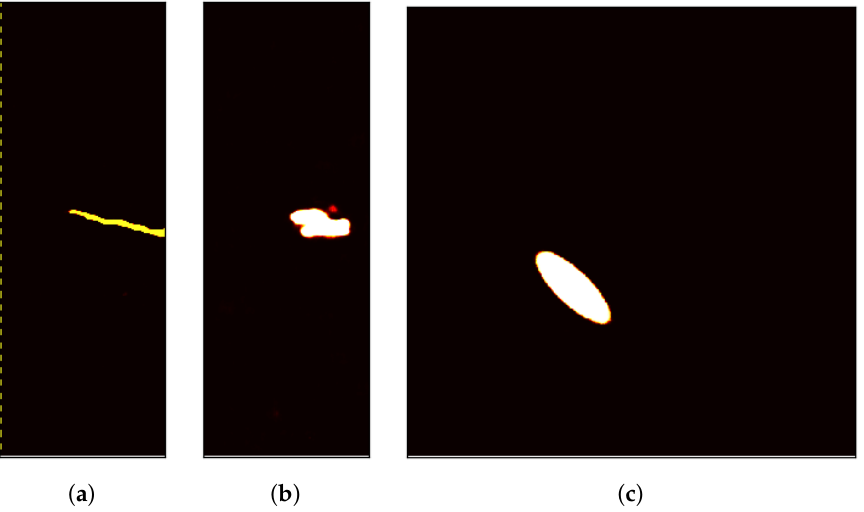
Figure 6. Examples of output image of segmentation network. ( a ) The example of KolektorSDD. ( b ) The example of KolektorSDD2. ( c ) The example of DAGM.